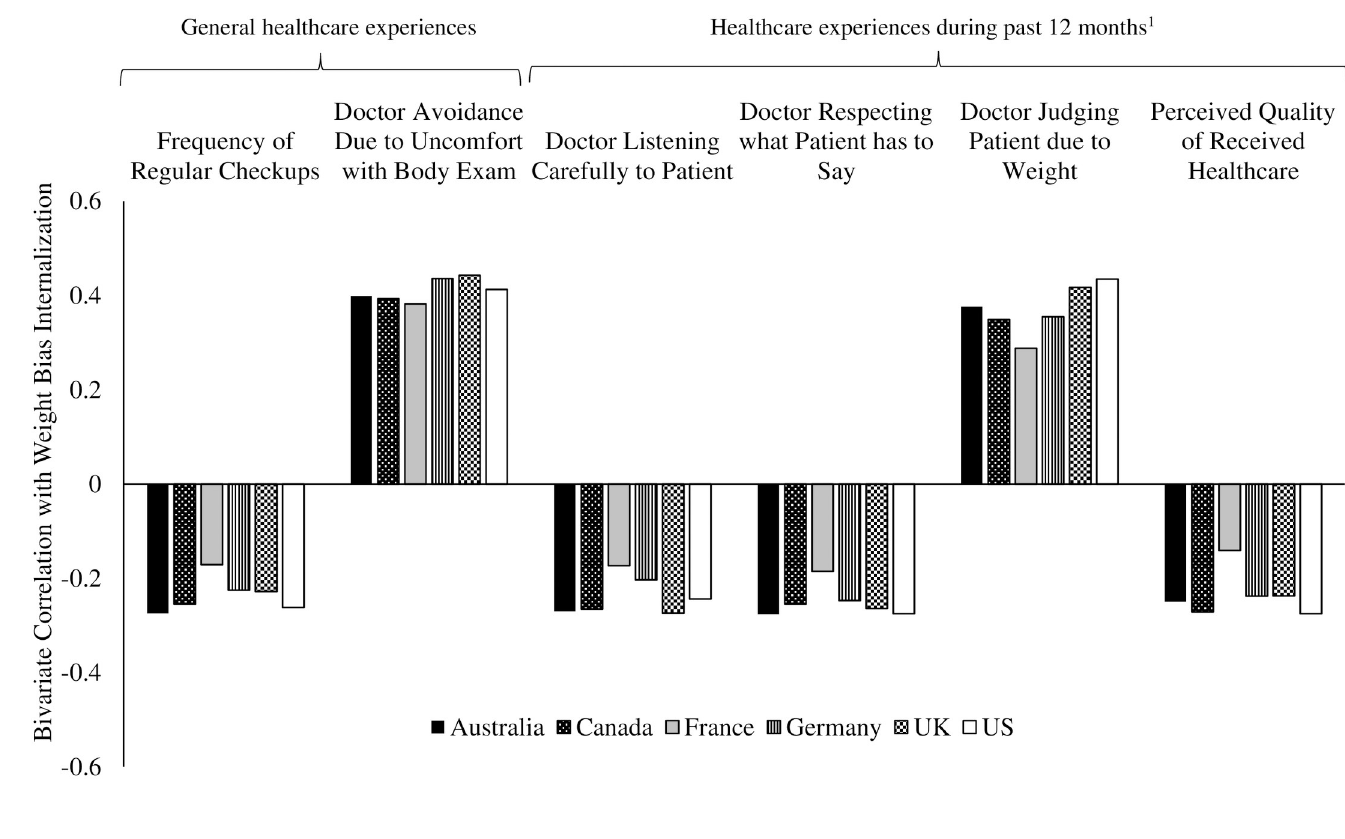
Fig 1. Bivariate correlations between weight bias internalization and (continuous) healthcare experience